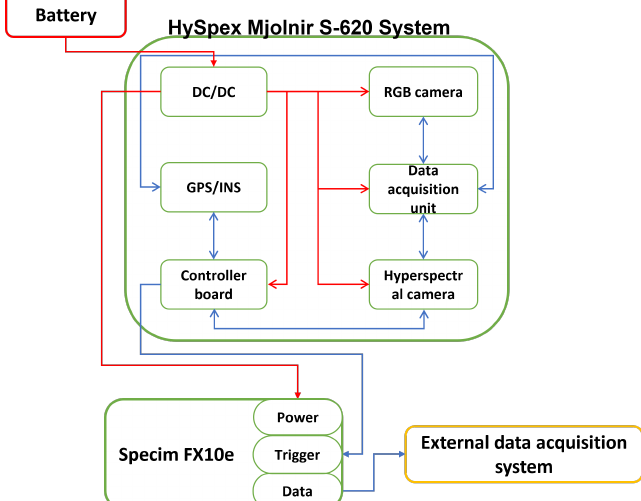
Figure 4. Hyperspectral imaging system hardware